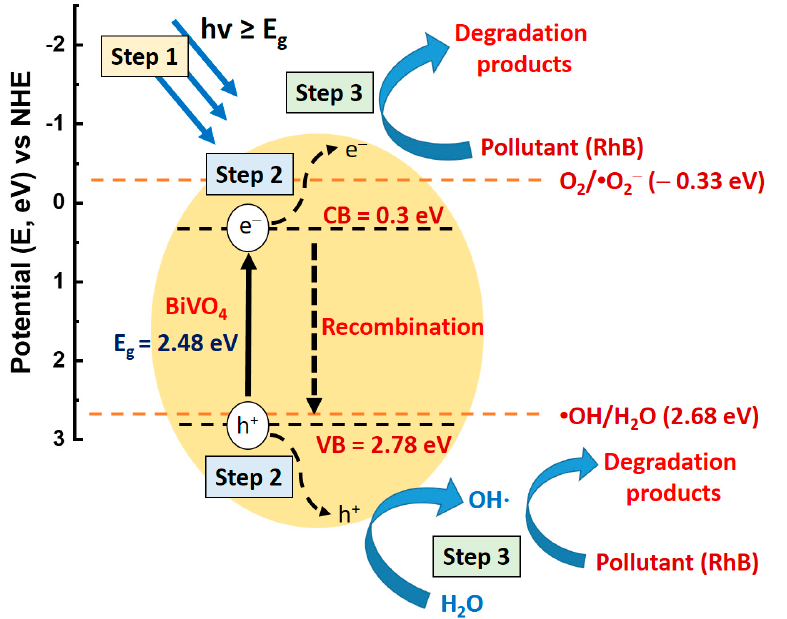
Figure 8. Schematic illustration of proposed photocatalytic reaction mechanism of BiVO 4 photocata- lyst under visible